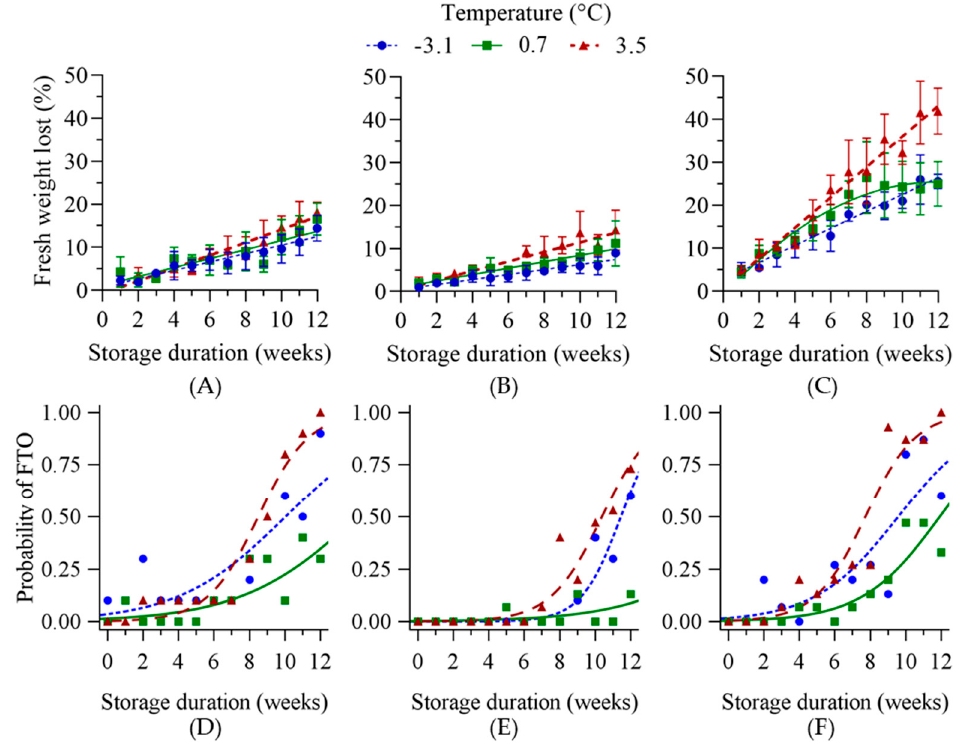
Figure 1. Exp1 fresh weight loss (%) ( A – C ) and probability of flowers that failed to open (FTO) ( D – F ) for Paeonia lactiflora cultivars Festiva Maxima ( A , D ), Monsieur Jules Elie ( B , E ), and Sarah Bernhardt ( C , F ) in response to three storage temperatures and thirteen storage durations. Buds that failed to open or flowers that partially opened and petals that did not complete reflex or unfold were labeled as FTO during post-storage evaluation. Flowers were considered deformed if petals did not fully expand, were missing, wrinkled, or exhibited some type of disfigurement. Markers for weight loss are the means along with ± SD ( n = 5) with linear or quadratic regressions. Logistic regressions are the predicted FTO probability along with the observed percentage that did occur as a decimal ( n = 15). Regression models and fit statistics are located in Tables S1–S3.